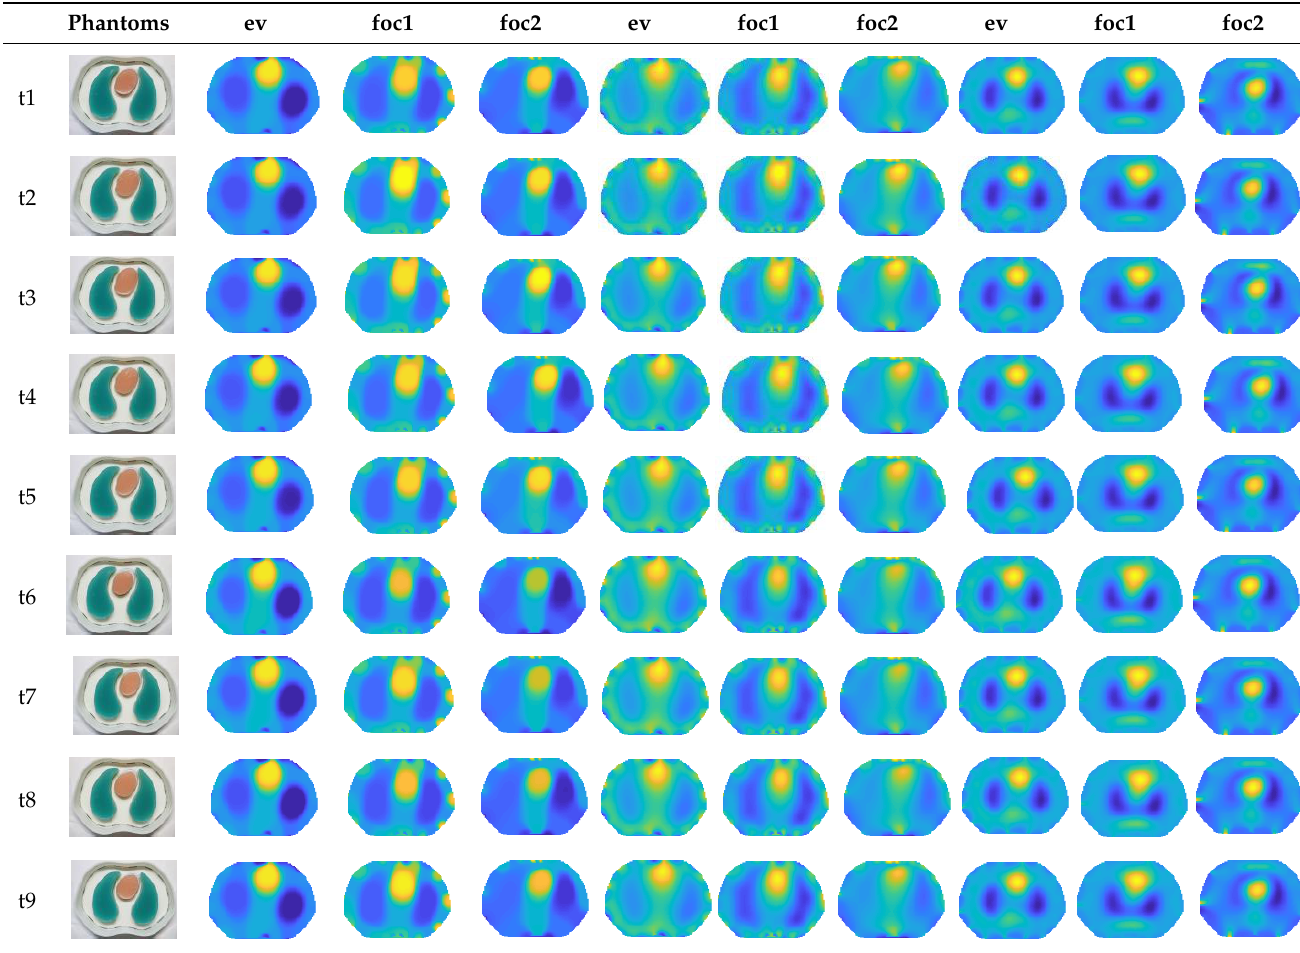
Table 3. Image reconstruction results from proposed optimized sensor and uniform sensor under different algorithms.